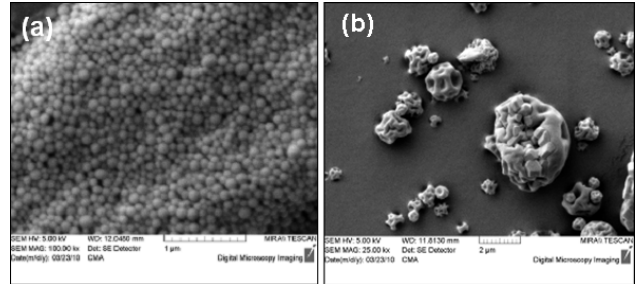
Figure 4. Scanning electron micrographs of trastuzumab containing (a) PLGA nanoparticles, (b) chitosan